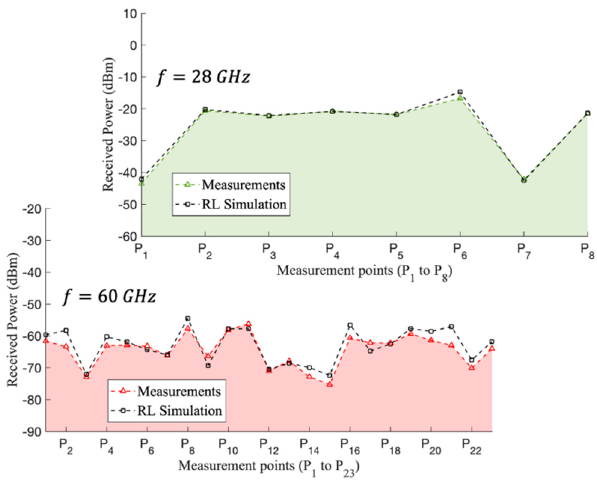
Figure 16. Experimental measurements and 3D-RL simulation comparisons at the 28 and 60 GHz frequencies along the different points depicted in Figure 9.